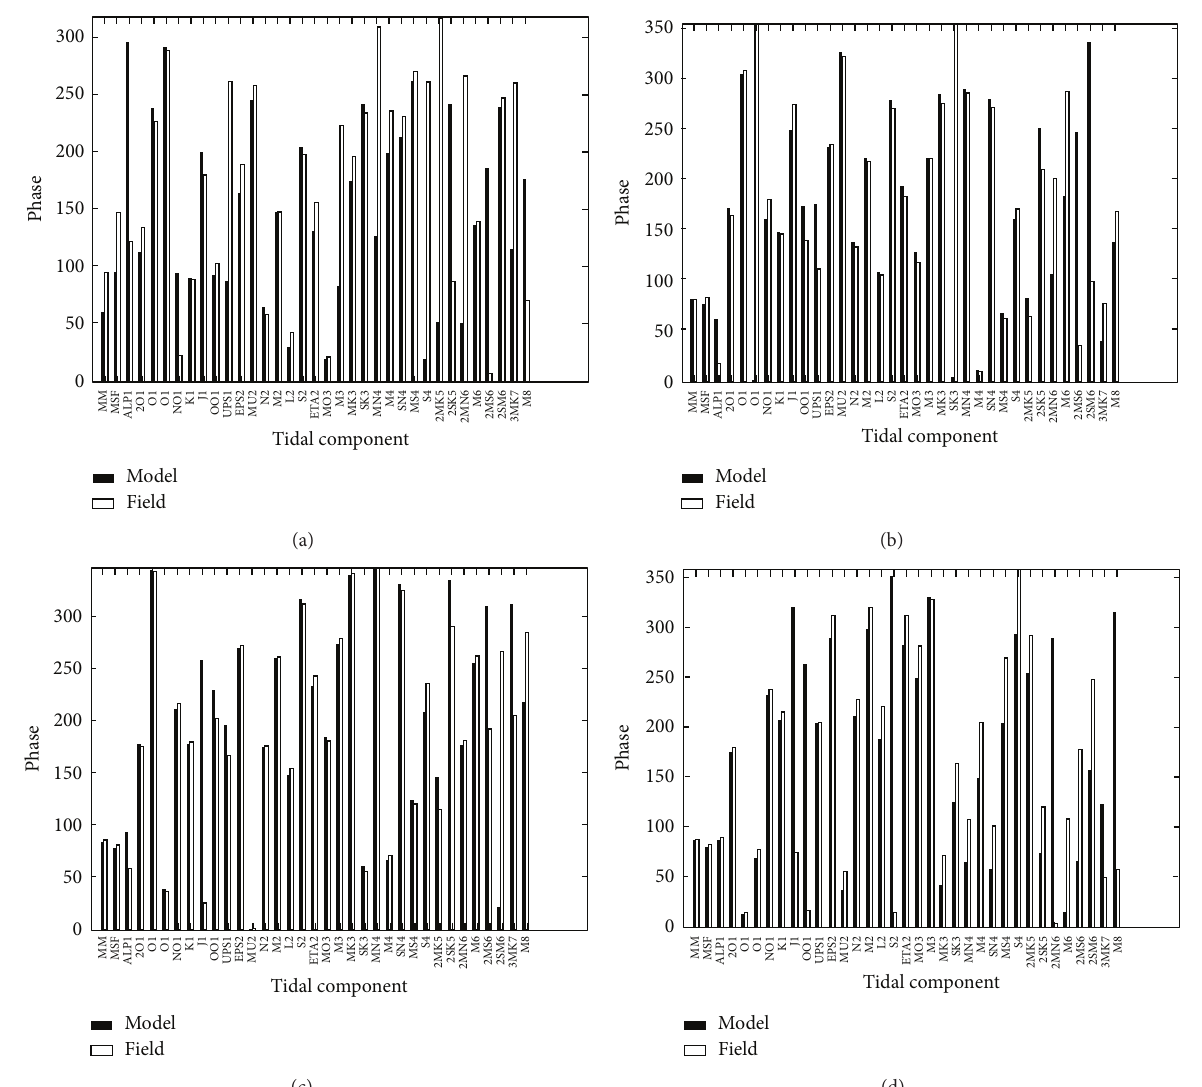
Figure 8: Tidal phase (degrees from Greenwich) (a) Astoria, (b) Longview, (c) Saint Helens, and (d)